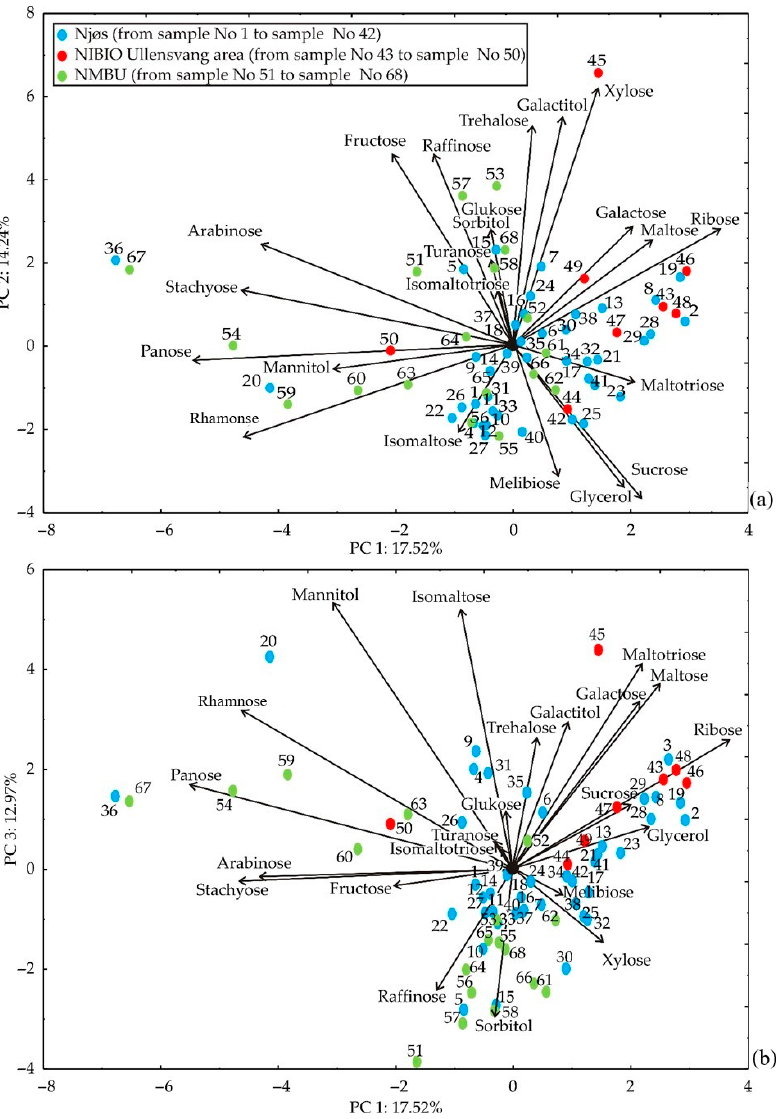
Figure 3. PCA ordination of sugars content variables: ( a ) projection in PC1-PC2 plane; ( b ) projection in PC1-PC3 plane.